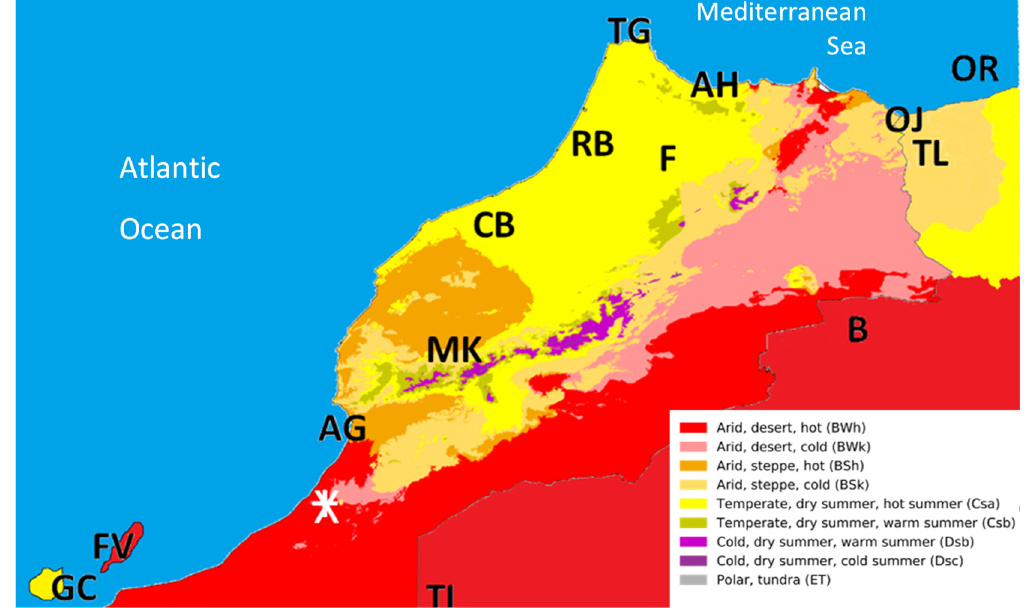
Figure 1. Köppen-Geiger climate classification map for the studied area concerning the period 1980–2016, from [25,26]. Meteo sites are indicated by letters (see Table 1 for the abreviations). The figure does not show the entire arid desert region (BWh climate) located at the south of the country. Right and inclined crosses (very close) represent Mirleft and Id Ouasskssou dew measurement sites. Table 1. Meteorological sites (airports) where atmospheric data are collected (8 stations in Morocco, 4 stations in Algeria and 2 stations in Spain) with typical climate and distance from the sea. They are sorted according to their longitude (west to east). The missing data fractions, in % of the total data, are also reported.